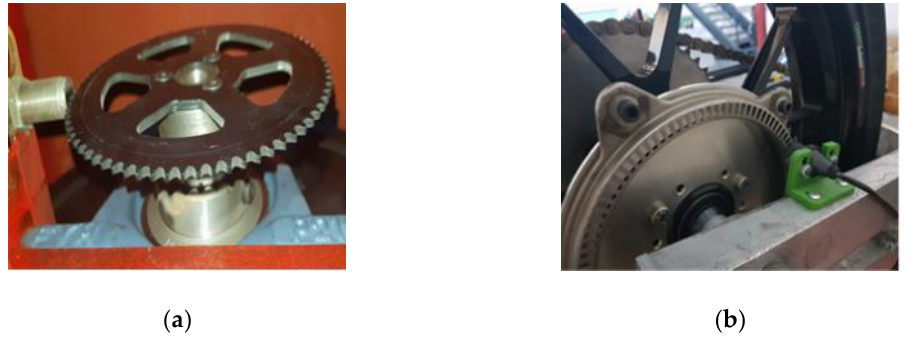
Figure 2. Angular speed sensors mounted on the test bench. ( a ) Roller angular speed and ( b ) wheel angular speed.